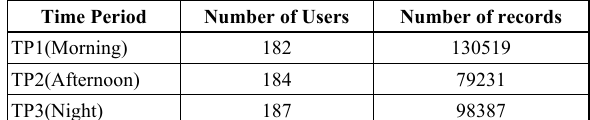
TABLE V. N UMBER OF USERS IN EACH CONTEXT